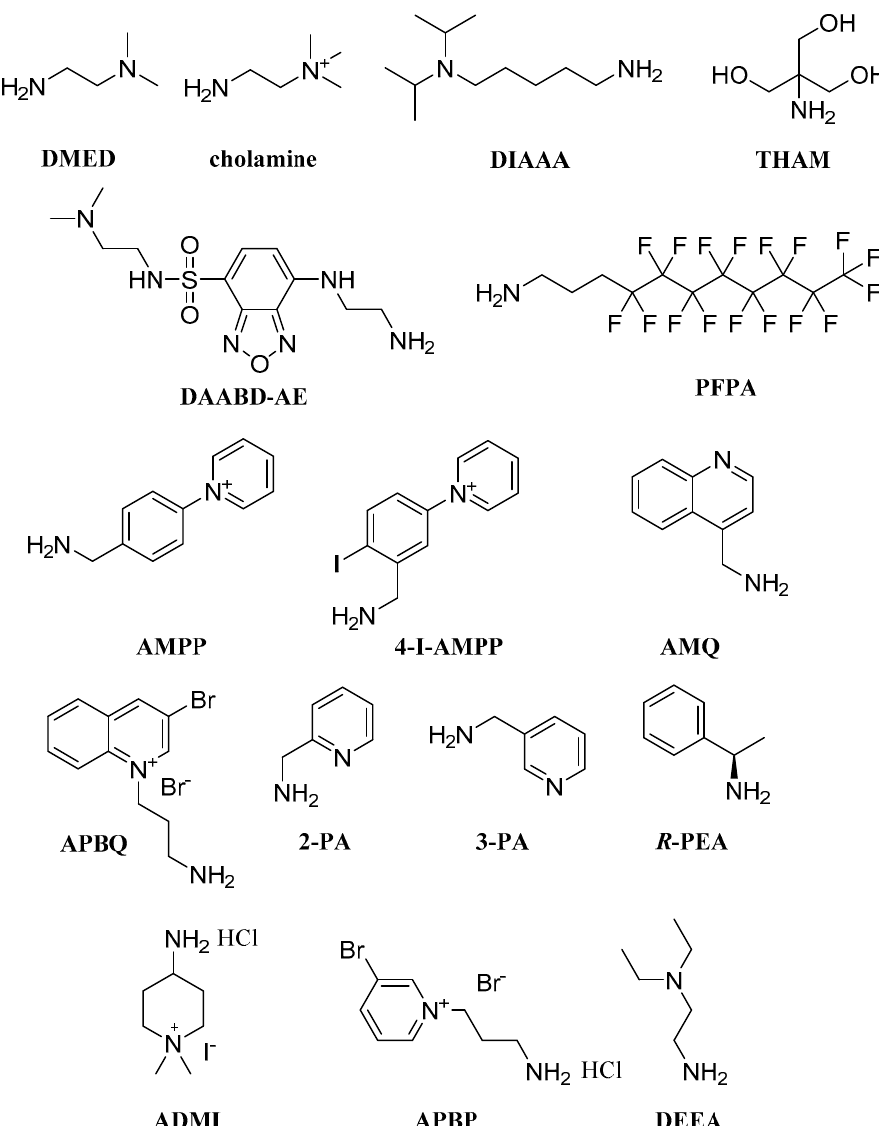
Figure 4. Primary amines as derivatization reagents for LC-HRMS analysis of